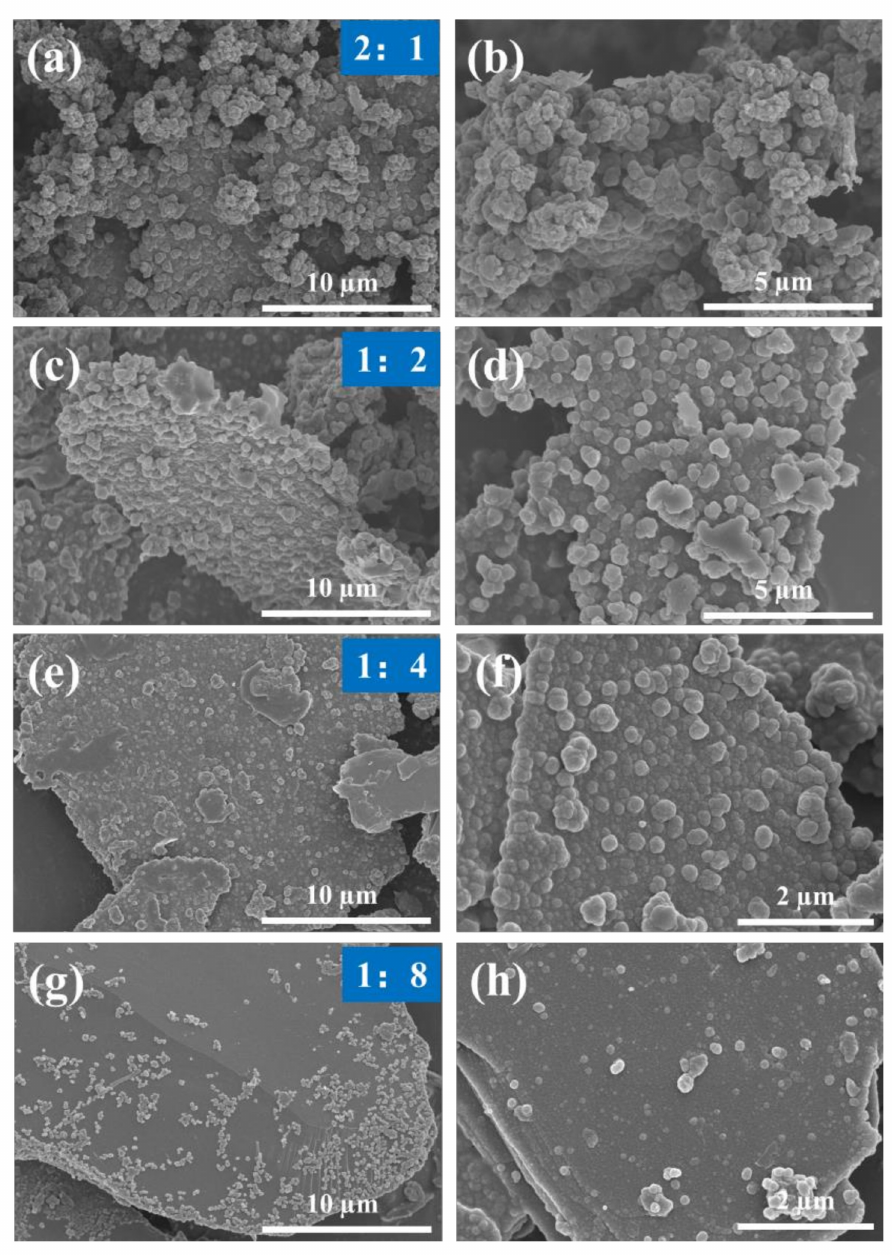
Figure 2. SEM image of PPy/SCP particles with the Py and SCP particles at the mass ratios 2:1 ( a ) and ( b ), 1:2 ( c ) and ( d ), 1:4 ( e ) and ( f ), 1:8 ( g ) and ( h ) with different magnifications of × 5k and ×